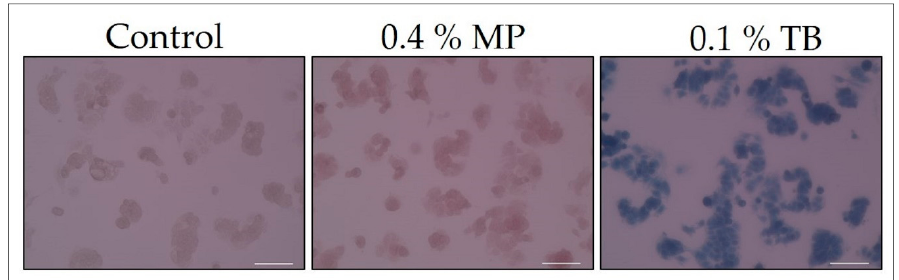
Figure 2. Confirmation of staining of dead cells (microwave treatment). All scale bars designate 100 μ m.